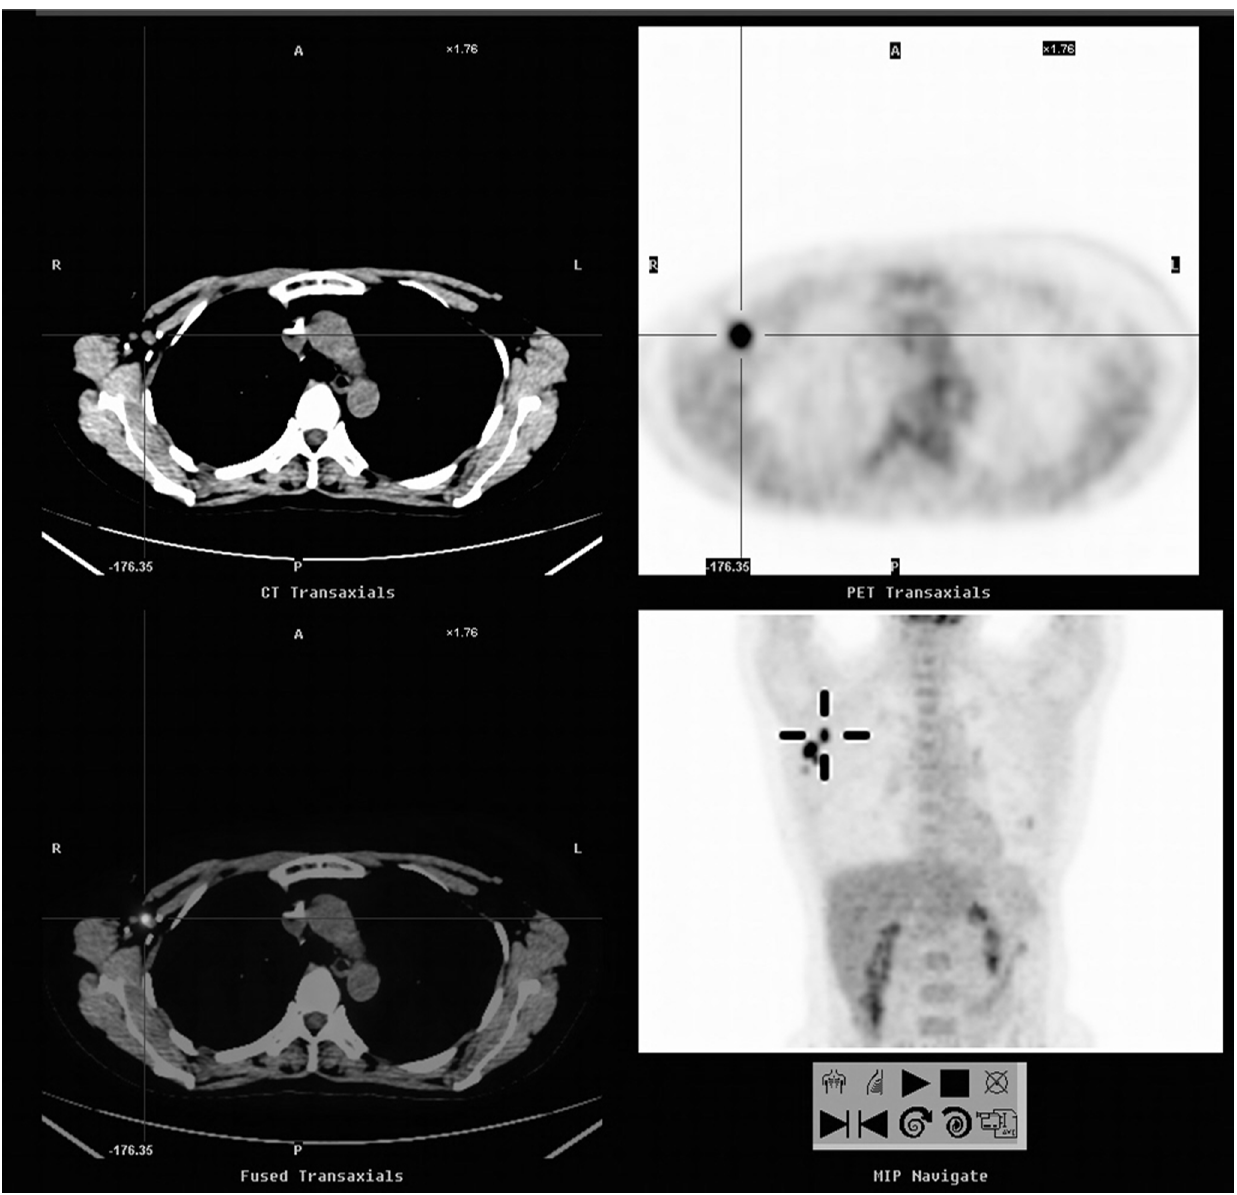
Fig. 2. A 46-year-old woman with a history of breast cancer (invasive ductal carcinoma of the right breast, stage IIIA) underwent a FDG-PET/CT scan for asymptomatic follow-up. FDG-PET/CT showed glucose hypermetabolism in the right axillary nodes (SUVmax 5 7.7, cross cursor). The pathological analysis confirmed the presence of metastatic lymph nodes. The patient’s serum CA 15-3 remained within normal ranges throughout the course. The patient remained on clinical follow-up at the end of the